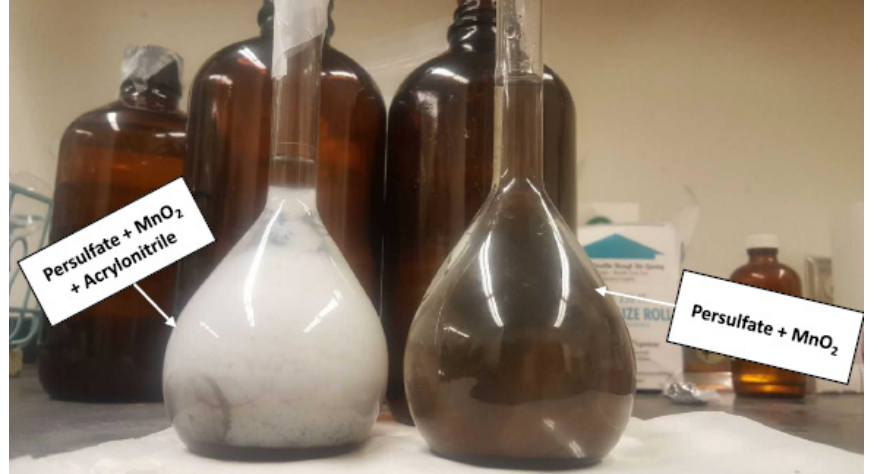
Figure 2. Picture of the persulfate (PS) in solution with addition of MnO 2 with (left) and without (right) the addition of acrylonitrile to each solution. White acrylonitrile-polymer formation indicated radical formation for PS with MnO 2 .